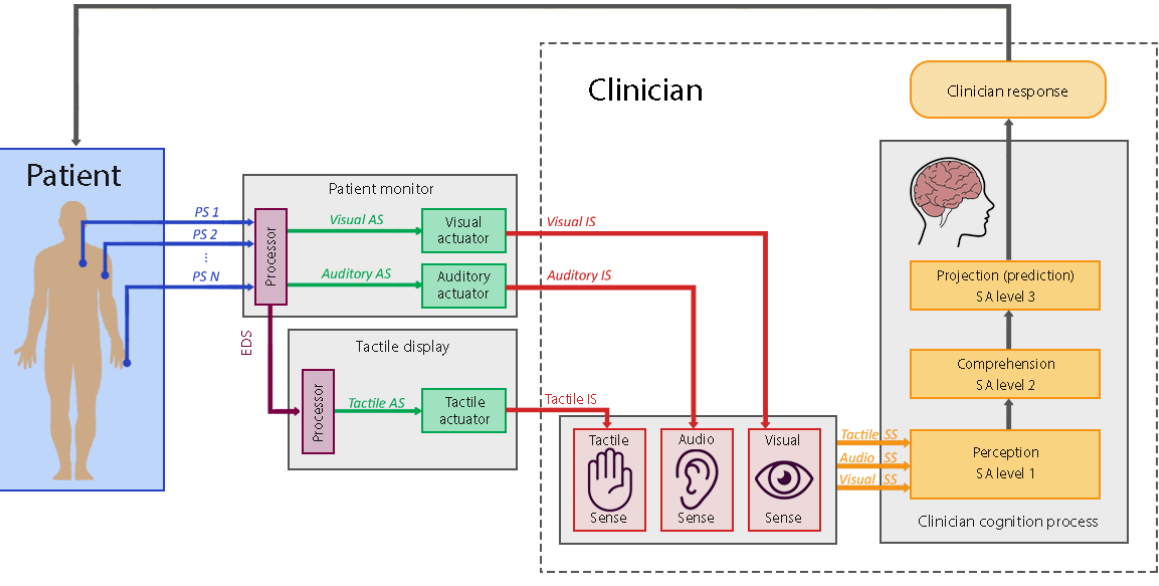
Figure 2. When a tactile display augments a patient monitor, the tactile display receives the patient data from the patient monitor, and this information is conveyed to the clinician using the clinician’s tactile sense through the delivery of vibration sequences. Tactile displays can be attached to different parts of the clinician’s body, such as the wrist, forearm, and waist. AS: actuator signal; EDS: external device signal; IS: interaction signal; PS: physiological signal; SS: sensory